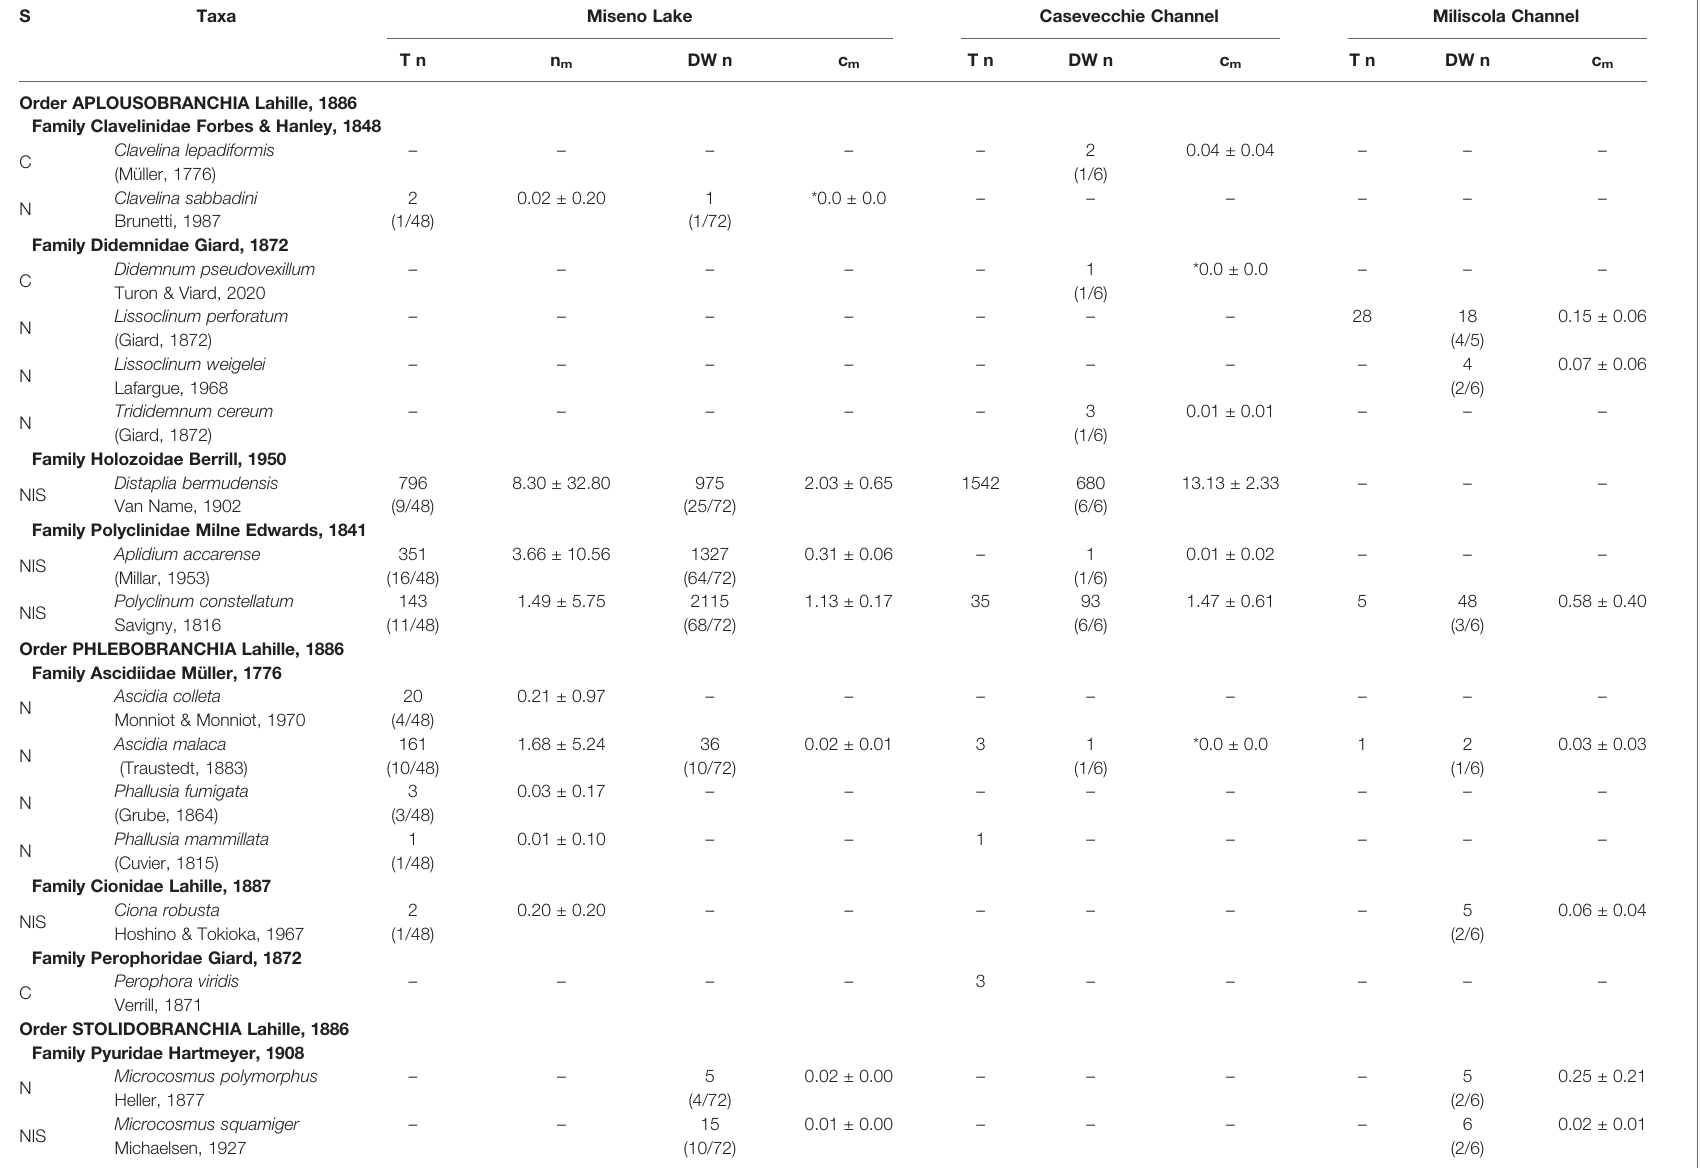
TABLE 1 | Surveyed ascidian species in the Miseno Lake, the Casevecchie channel, and the Miliscola channel, with known status (S: C, cryptogenic; N, native; NIS,